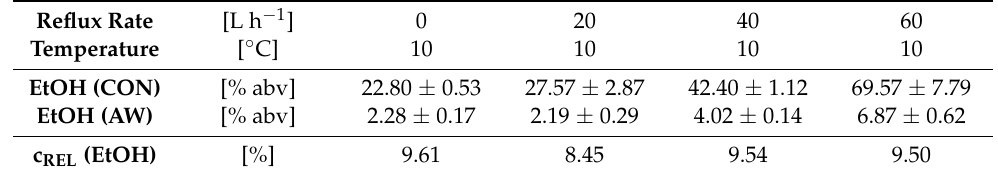
Table 2. Ethanol (EtOH) concentration (𝑥̅ ± 𝜎) in the condensate (CON) and aromawater (AW) at different values for the reflux rate; c REL (EtOH) represents the percentage ratio between the EtOH concentration in the AW to its level in the CON.